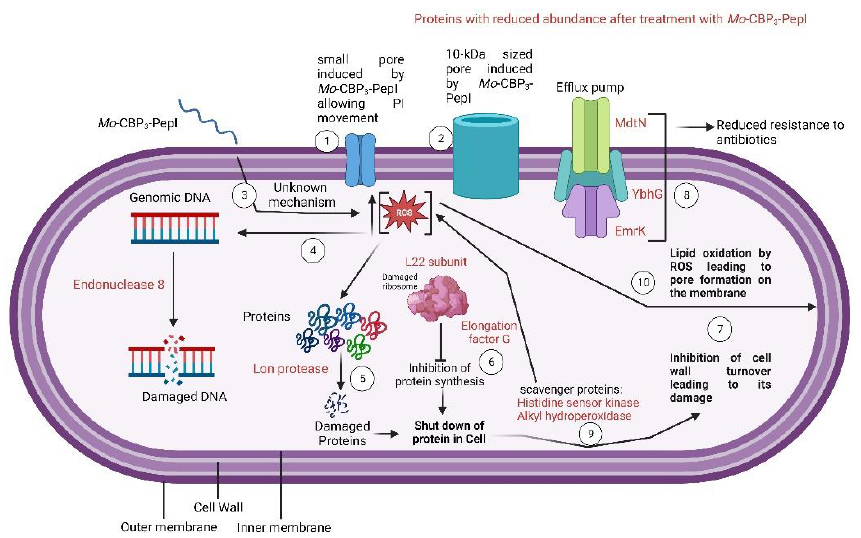
Figure 7. Scheme showing the mechanisms of antibacterial action of Mo -CBP3-PepI against K. pneumoniae . This scheme was produced only with proteins that decreased in abundance. The numbers explain important process. All them are explained in the text.